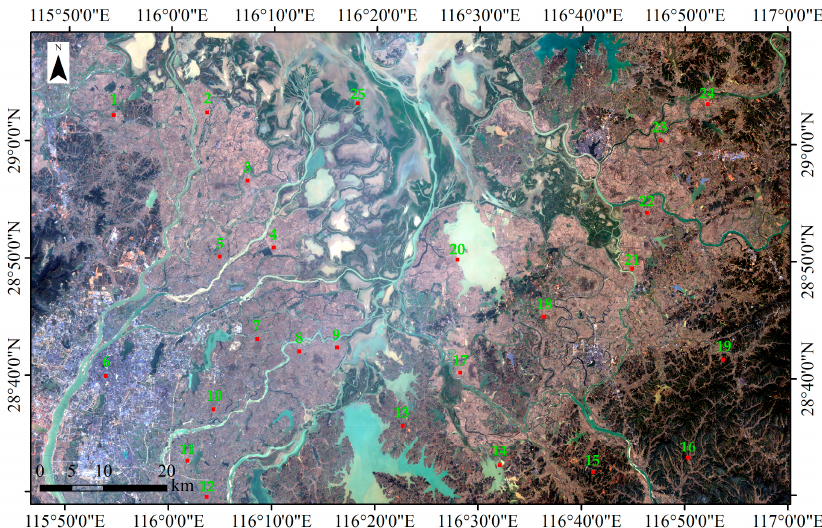
Figure 3. Distribution of field survey quadrats in the study area (red rectangles). The digital with green color was the quadrat number. There were 25 quadrats, each measuring 600 m square. The base map is a Landsat-8 true-color image (RGB: 432) of the study area taken on 16 December 2016.